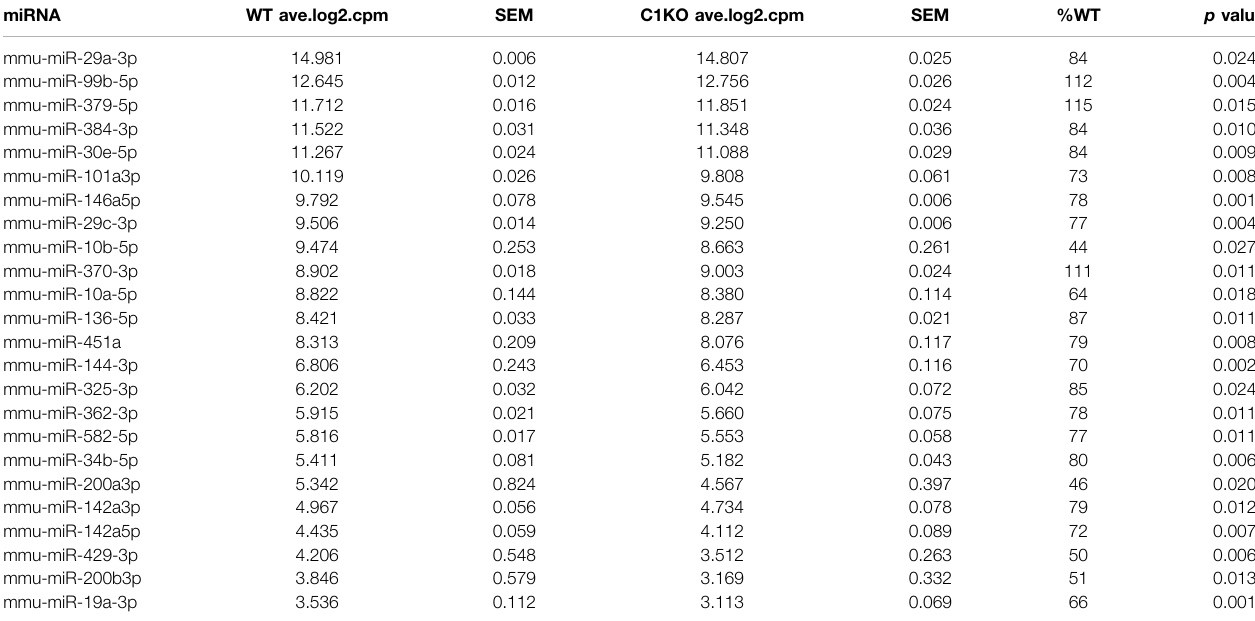
TABLE 2 | Differentially expressed miRNAs related to neurogenesis in brains of C1KO, as compared to WT mice. miRNA WT ave.log2.cpm SEM C1KO ave.log2.cpm